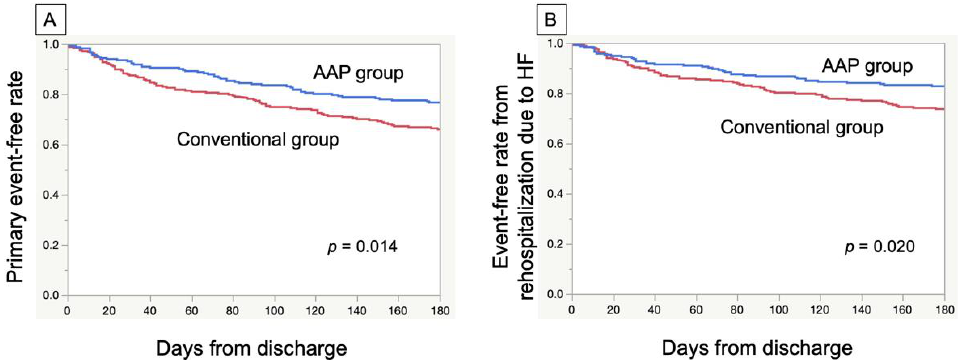
Figure 2. Kaplan–Meier curves for the period to a cardiac event. Subjects were divided into the AAP and conventional groups. ( A ) Primary composite endpoint. ( B ) Rehospitalization due to HF. AAP = acute-phase ambulation program; HF = heart